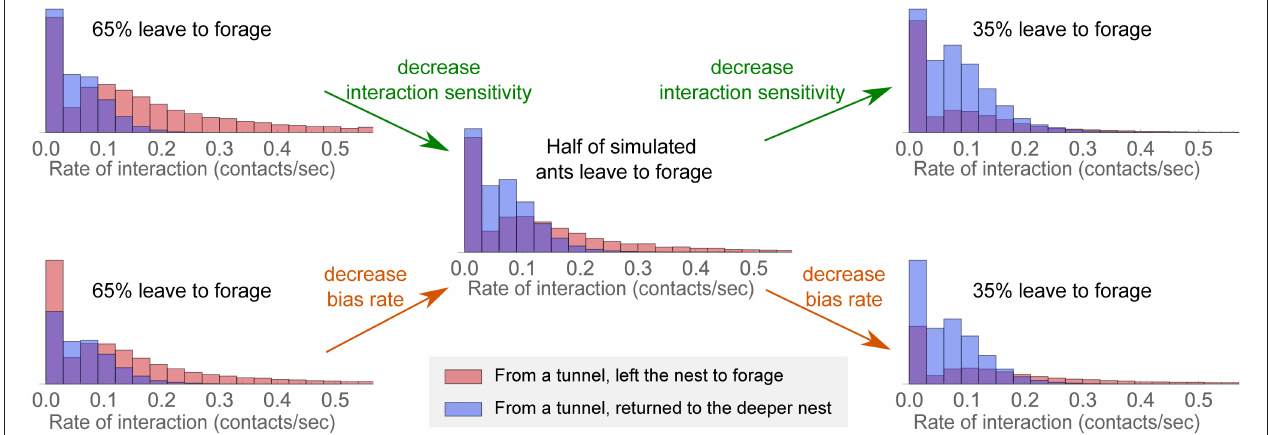
FIGURE 10 | Possible mechanisms underlying regulation of foraging rate. The fraction that leave the nest to forage f (shown decreasing progressively from the left column to the right column) depends on the interaction sensitivity k and constant bias rate γ . Individual panels show the interaction rate distributions for simulated ants that left the nest to forage vs. those that returned to the deeper nest. Parameter values of s 0 , σ , and r in were used from Figure 6A , and the evidence parameters k and γ were given the following values: ( left-top ) k = 0.36, γ = − 0.038, ( left-bottom ) k = 0.22, γ = − 0.023, ( middle ) k = 0.22, γ = − 0.038, ( right-top ) k = 0.026, γ = − 0.038, ( right-bottom ) k = 0.22, γ = −